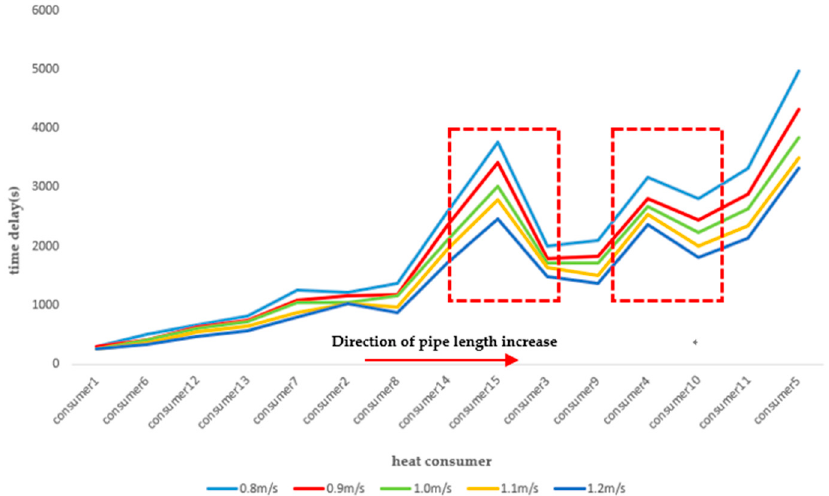
Figure 10. The relationship between the pipe length and the time delay of each heat consumer. Table 6. Correlation pipeline parameters of each consumer.